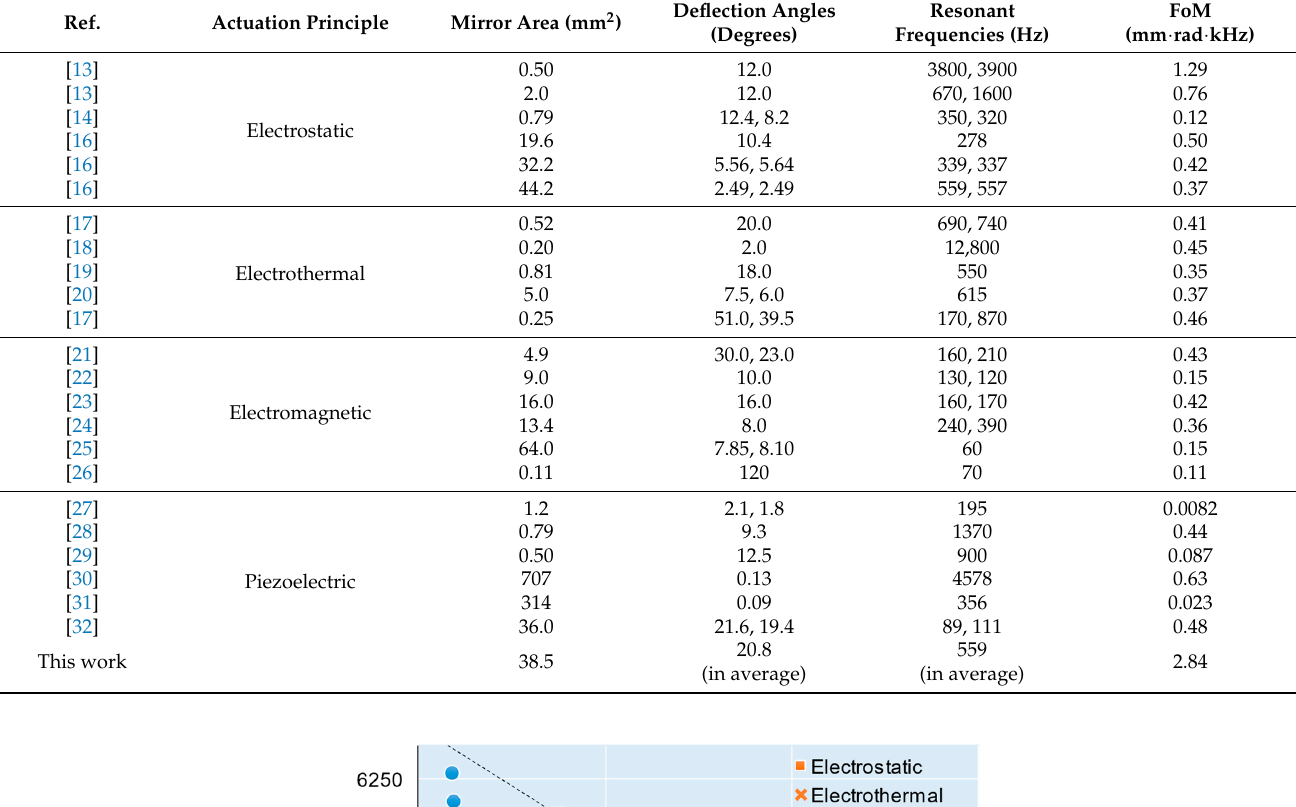
Table 1. Comparison of 2-DoF mechanical quasi-static scanners.